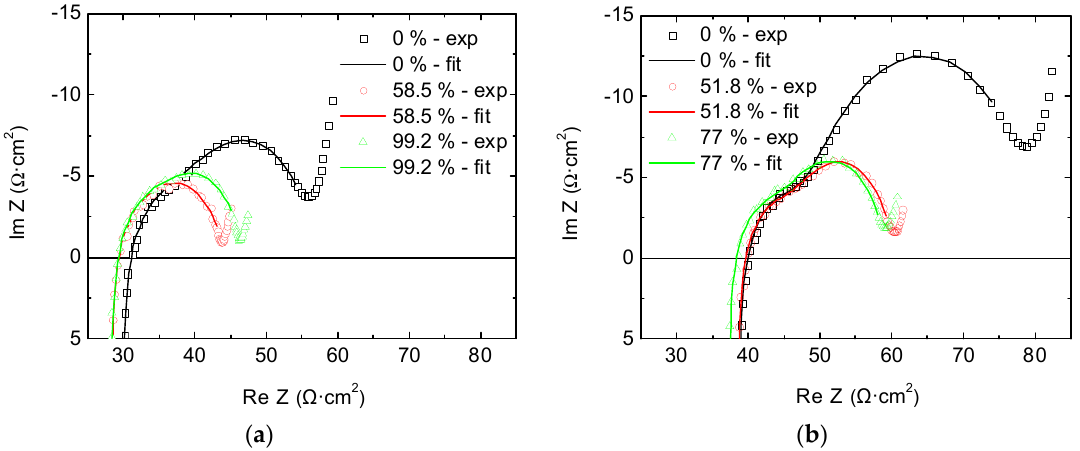
Figure 10. Experimental and fitted impedance spectra from 1 Hz to 10 kHz of ( a ) a fresh LCO-NMC/graphite cell at SoCs 0%, 58.5%, and 99.2% and ( b ) an aged LCO-NMC/graphite cell at SoCs 0%, 51.8%, and 77%. Open symbols represent experimental data and solid lines represent the data obtained from the fitted electrical model represented in Figure 9.